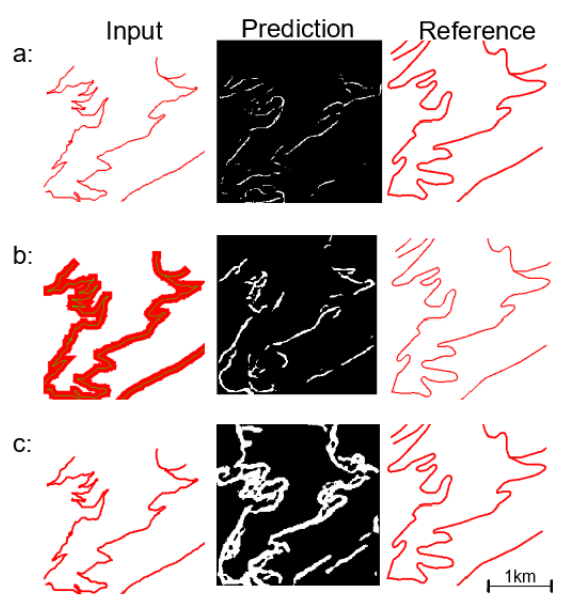
Figure 12. Bias correction effect for the object-based approach: ( a ) without correction, the road width is fixed; ( b ) enlargement relative to the deformation rate (red) and road shape (green); ( c ) moderate enlargement relative to the deformation rate.